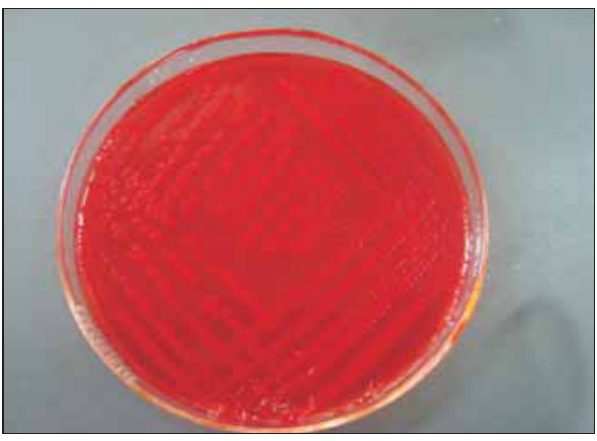
Figure-1: E. coli showing brick red colonies on Congo red medium